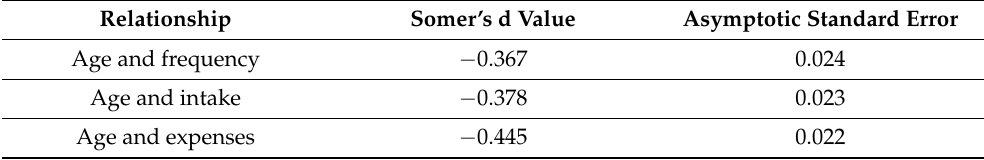
Table 5. Summary of Somers’ d values for age